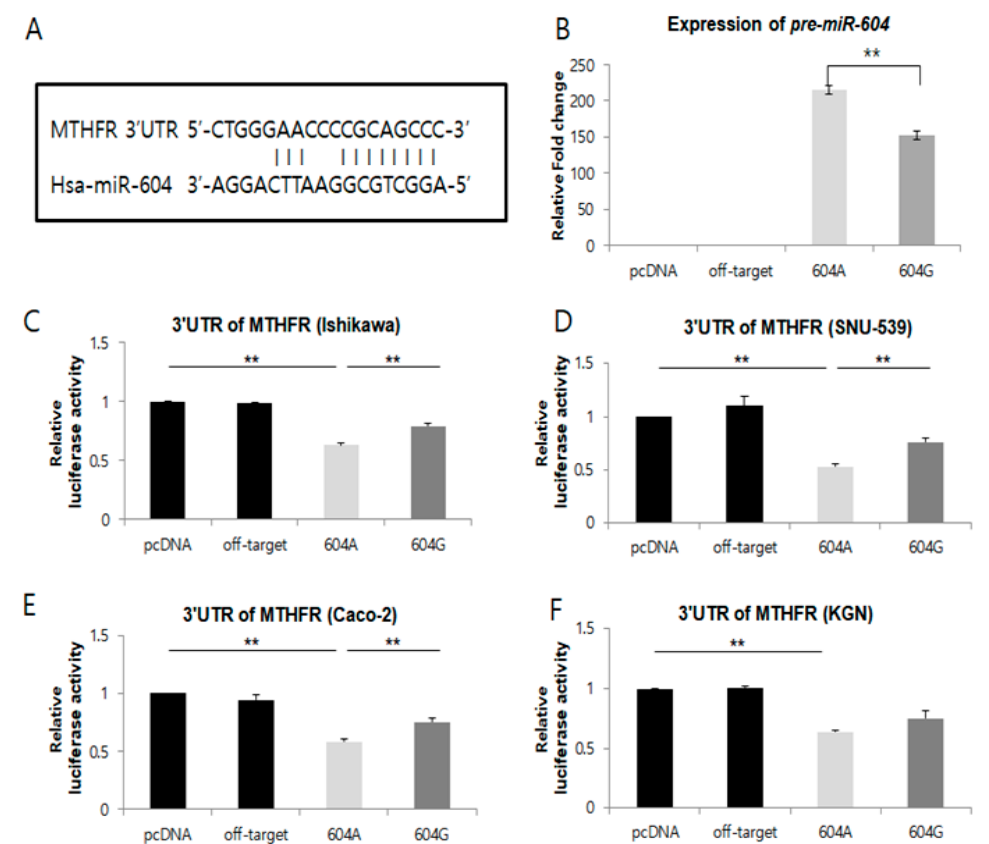
Figure 1. The microRNA, miR-604, regulates MTHFR mRNA via a targeting sequence located in the 3 (cid:48) UTR of this gene. ( A ) A schematic representation of putative target genes with 3 (cid:48) -UTRs that contain possible miR-604 -A and miR-604 -G binding sites in conserved regions. ( B ) Expression of miR-604 A>G. Levels of miR-604 were detected using microRNA RT-PCR in cells transfected with the empty pCR3.1 vector, pCR3.1-miR-offtarget, pCR3.1- miR-604 -AA, or pCR3.1- miR-604 -GG. U6 snRNA was used as an internal control, with the relative level of miR-604 normalized to U6. ** p < 0.05. ( C – F ) Dual-luciferase reporter assays were performed to test the interaction of hsa-miR-604 and its targeting sequence in the MTHFR 3 (cid:48) UTR using constructs containing the predicted targeting sequence (pGL4.13- MTHFR 3 (cid:48) UTR) cloned into the 3 (cid:48) UTR of the reporter gene. Data represent three independent experiments with triplicate measurements. ** indicates p < 0.05.